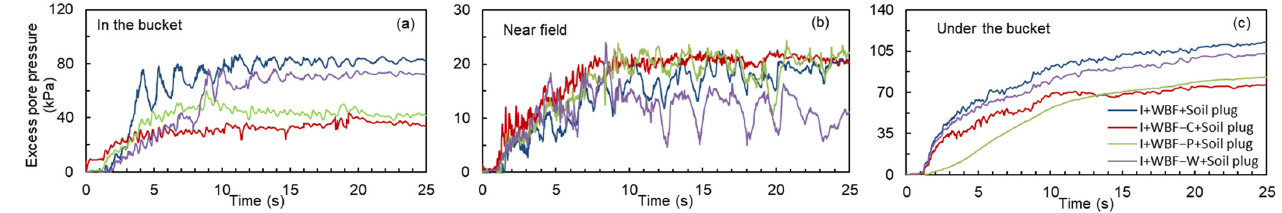
Figure 14. Excess pore pressure time histories of seabed soil near different types of reinforced bucket foundation used in inclined seabeds: ( a ) seabed soil in the bucket at 2.0 m depth; ( b ) near field seabed soil at 2.0 m depth; ( c ) seabed soil under the bucket at 12 m depth .